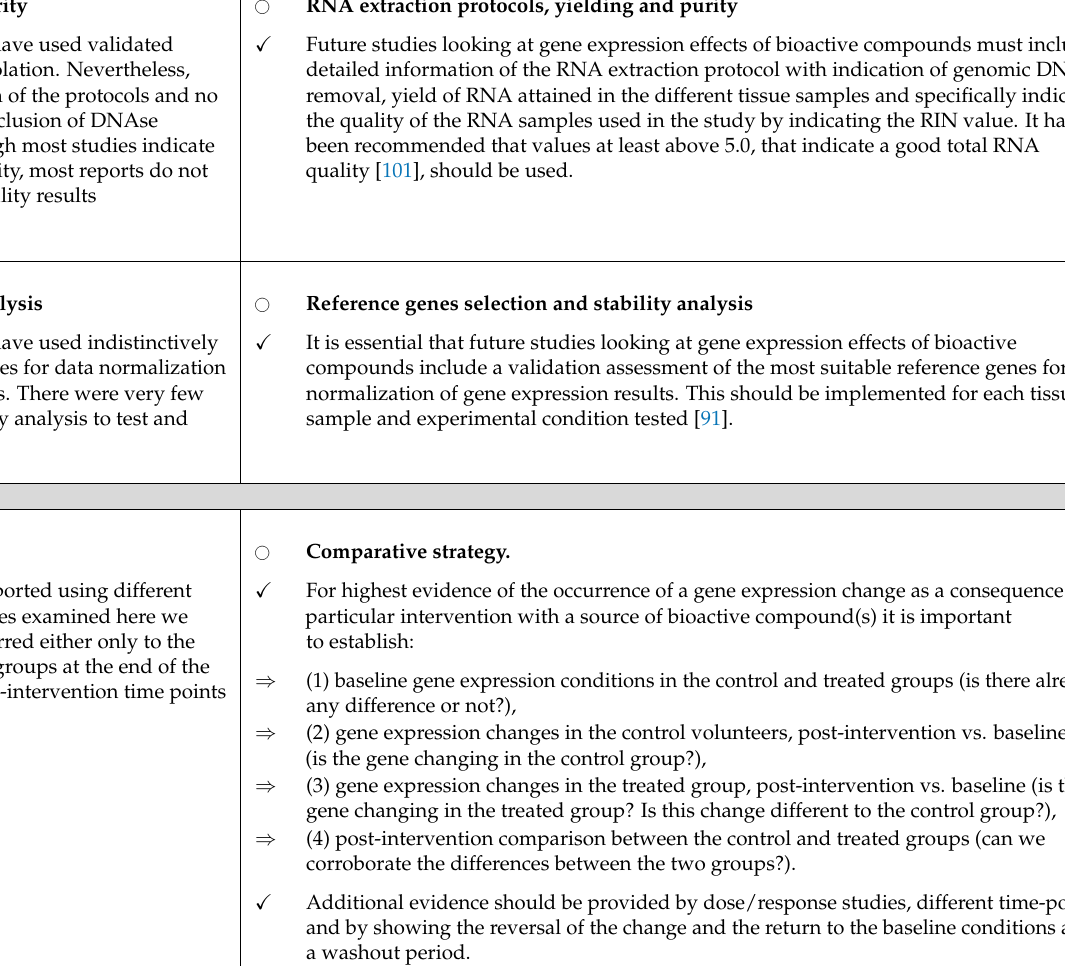
RNA extraction protocols, yielding and